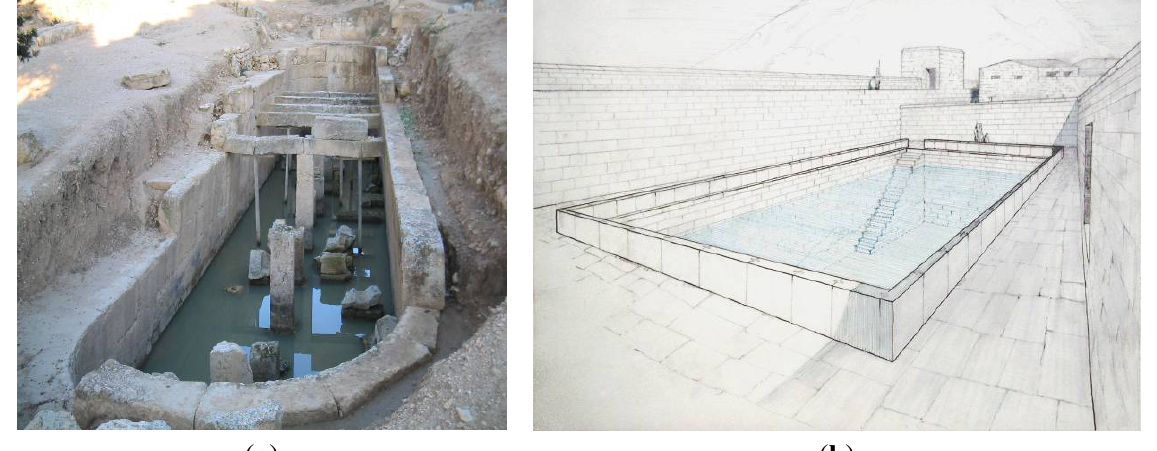
Figure 3. ( a ) The slab-covered cistern of the Sanctuary of Heraion at Loutraki Attika and ( b ) Open air public cistern at Orraon (modified by G.